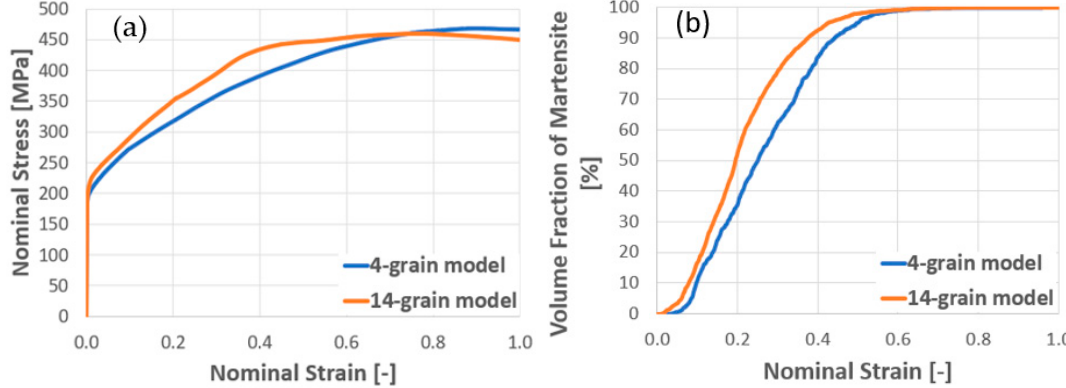
Figure 10. ( a ) Nominal stress versus nominal strain and ( b ) the volume fraction of martensite versus nominal strain with random initial crystallographic orientation in each grain.